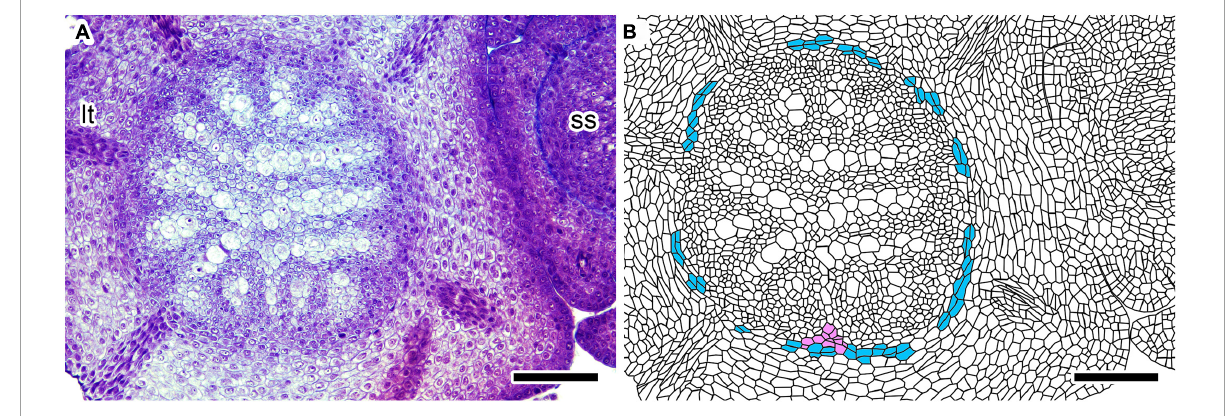
FIGURE3 Cross-section of an immature Lycopodium clavatum shoot (sample #P1) at 665 µ m from the shoot apex. (A) Original section. (B) Line drawing of (A) . See color legend for Figure 2 . Scale bars, 100 µ m. ss, small shoot; lt, leaf